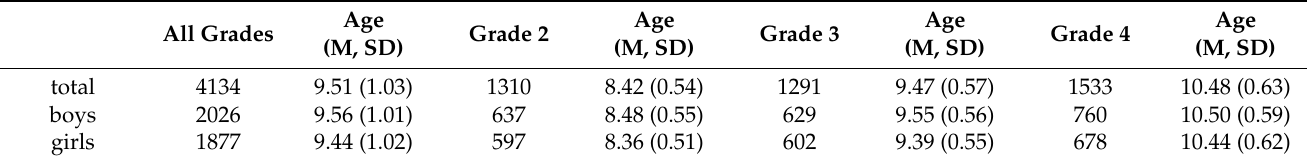
Table 1. The number of participants and their age (years) in different